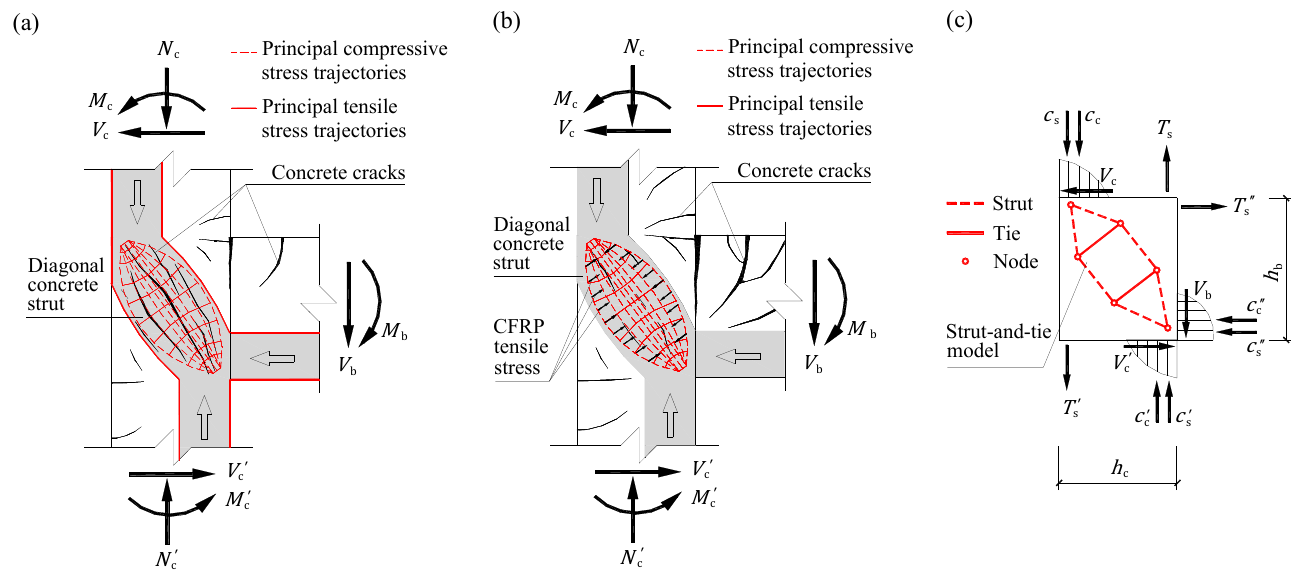
Figure 13. Shear mechanism of CFRP-retrofitted exterior beam-column joints. ( a ) Classical compres- sion strut mechanism formed in lightly reinforced concrete beam-column joints; ( b ) Role of exter- nally bonded CFRP sheets on enhancing shear behavior of joint panel; ( c ) Proposed strut-and-tie model.